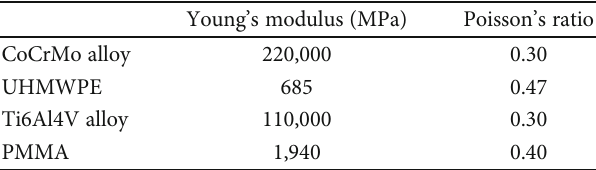
Table 1: Material properties of the FE